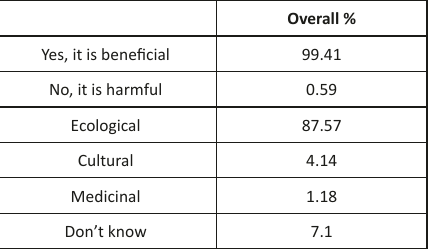
Table 3. Respondents’ answers to whether they think a pangolin is beneficial or harmful